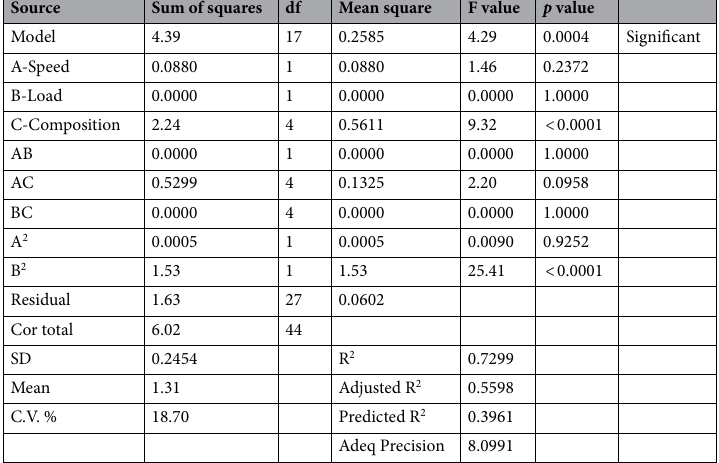
Table 5. ANOVA and summary of fit statistics for response 1 (wear rate).